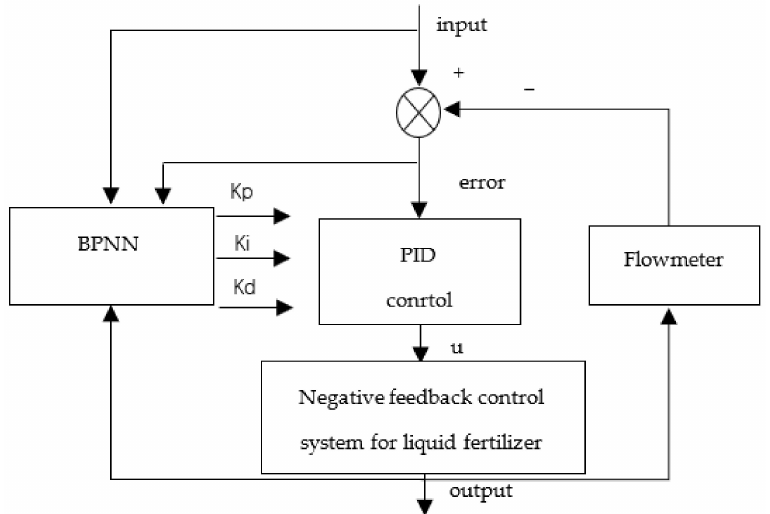
Figure 5. BPNN–PID dominant system flow